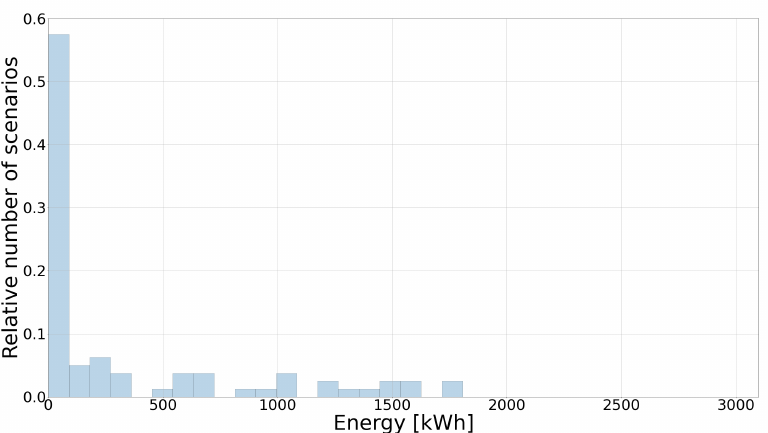
Figure 20. Histogram of M R values for PV generation increased by a factor of 1.2 and re-trained RL